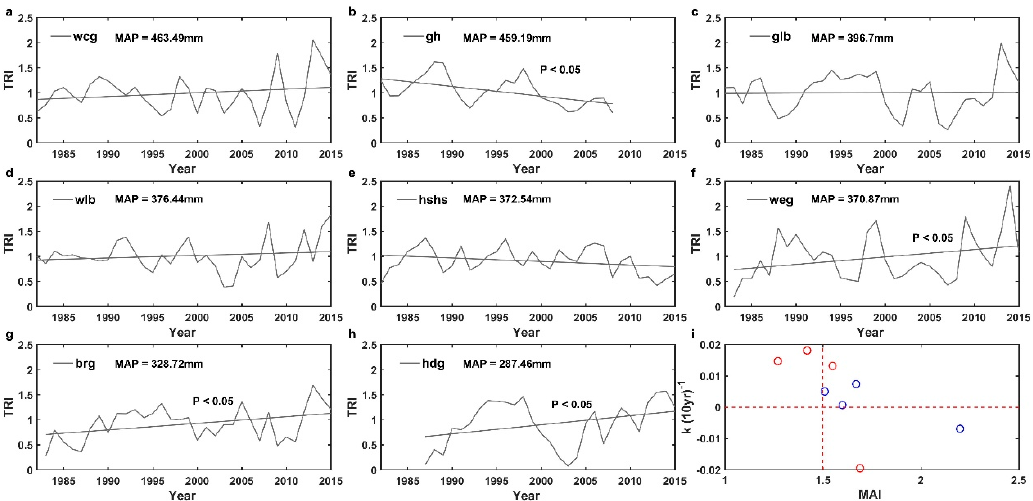
Figure 3. The interannual variability of eight tree-ring index (TRI) chronologies ( a–h ) over northeastern China in period of 1982 to 2015 and the distribution of their linear trends along with MAI ( i ). MAP is the mean annual precipitation. Red and blue points in ( i ) represent the plots of significant trend and nonsignificant trend at statistical significance of p < 0.05 with Student’s t -test, respectively.